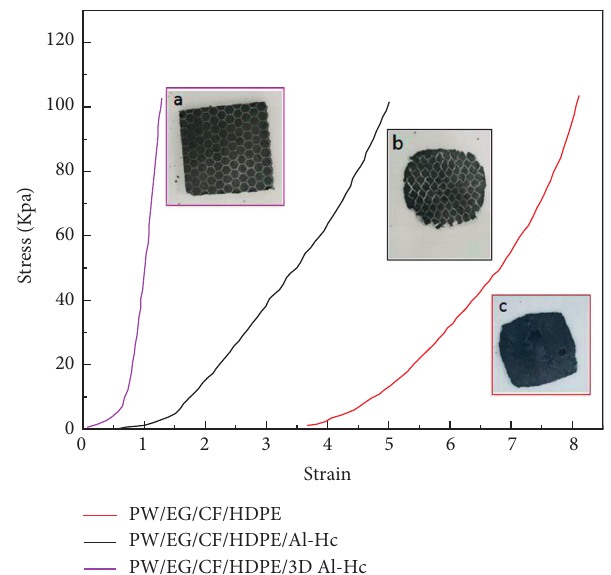
Figure 11: Stress-strain curves and images of the CPCM specimens after the compression strength test. (a), (b), and (c) are the images of the samples after the compression strength